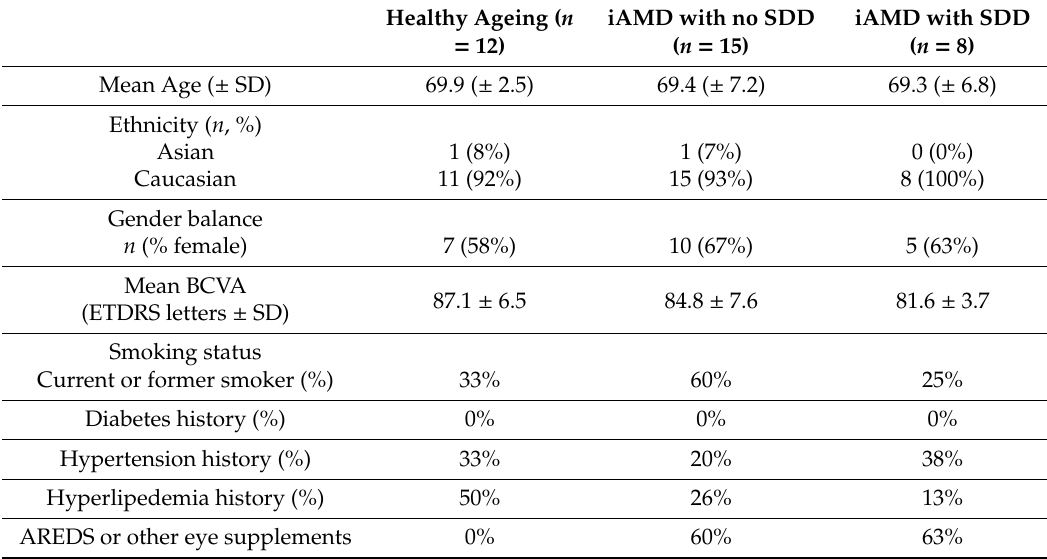
Table 1. Participant characteristics in each group at baseline visit who completed 12 month study